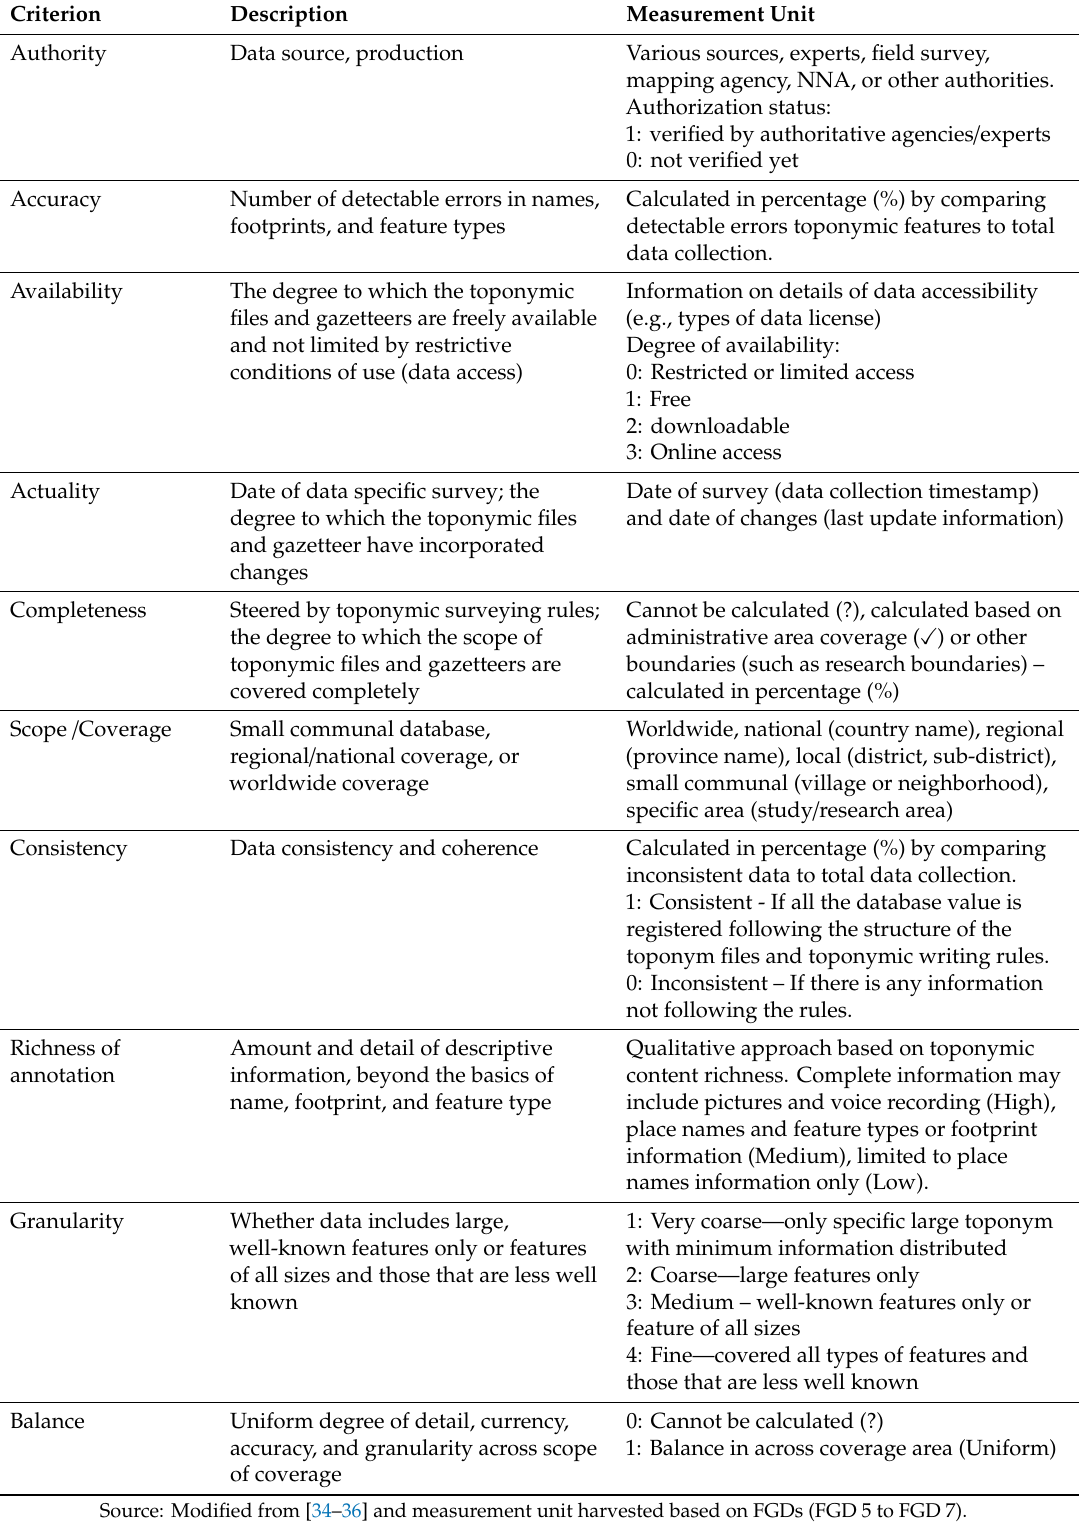
Table A1. Details of verification criteria for toponymic files and